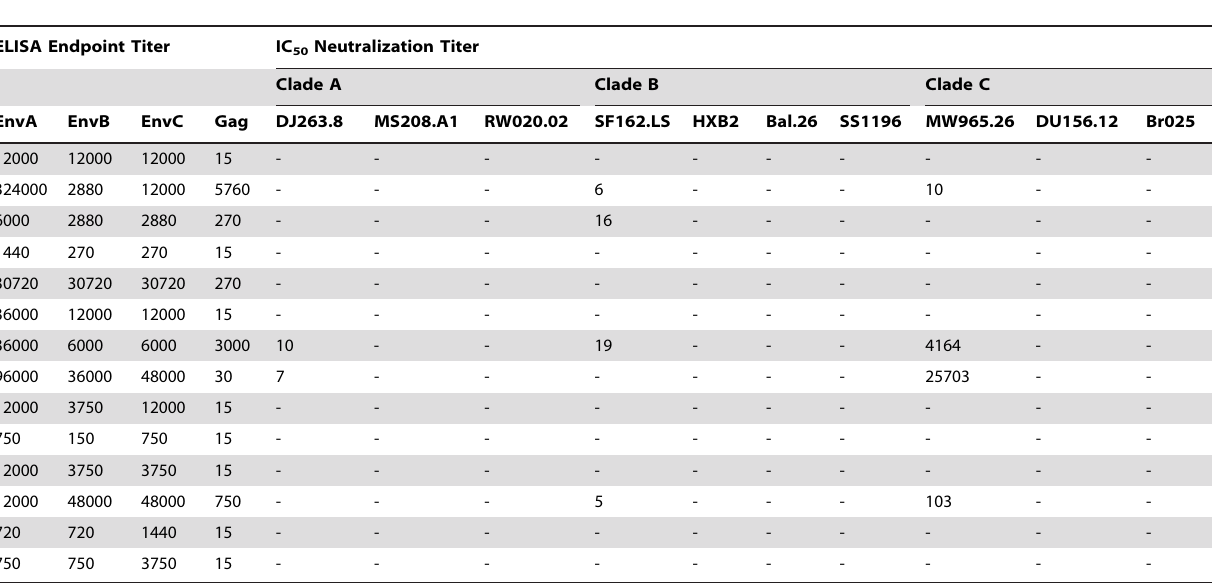
Table 3. Antibody responses induced in subjects after priming with DNA and boosting with rAd5 vaccines.